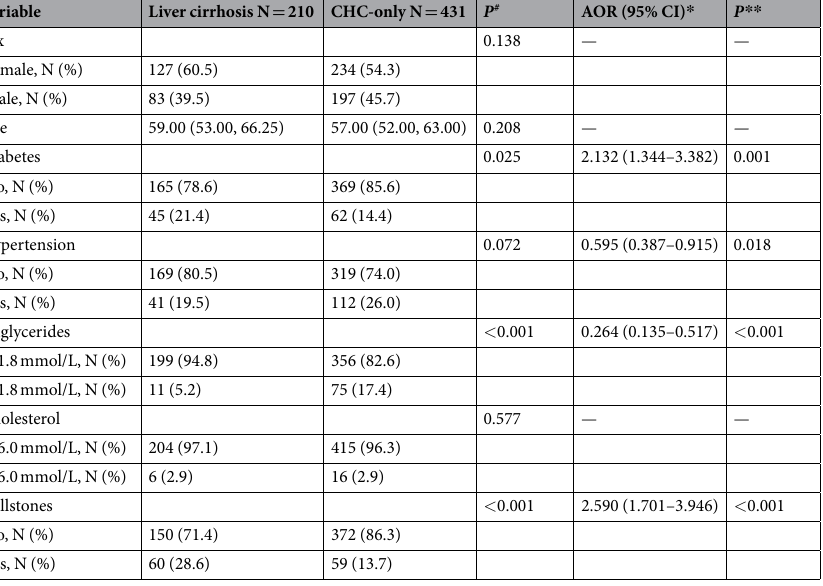
Table 2. Univariate and multivariate analyses of variables associated with hepatitis C virus-related liver cirrhosis. CHC = chronic hepatitis C; AOR = adjusted odds ratio; CI = confidence interval. # P value for univariate analysis. * Adjusted for gender, age, hypertension, triglyceride, cholesterol, gallstones, and diabetes ** P value for multivariate